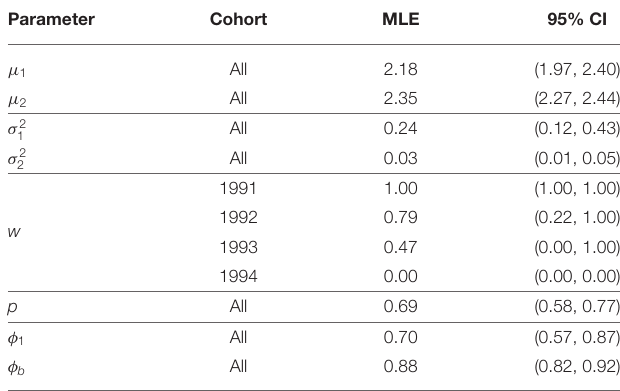
TABLE 3 | Fitted models with AIC and 1 AIC scores for the Isle of May gray seal study first-time and return breeder model. Distribution